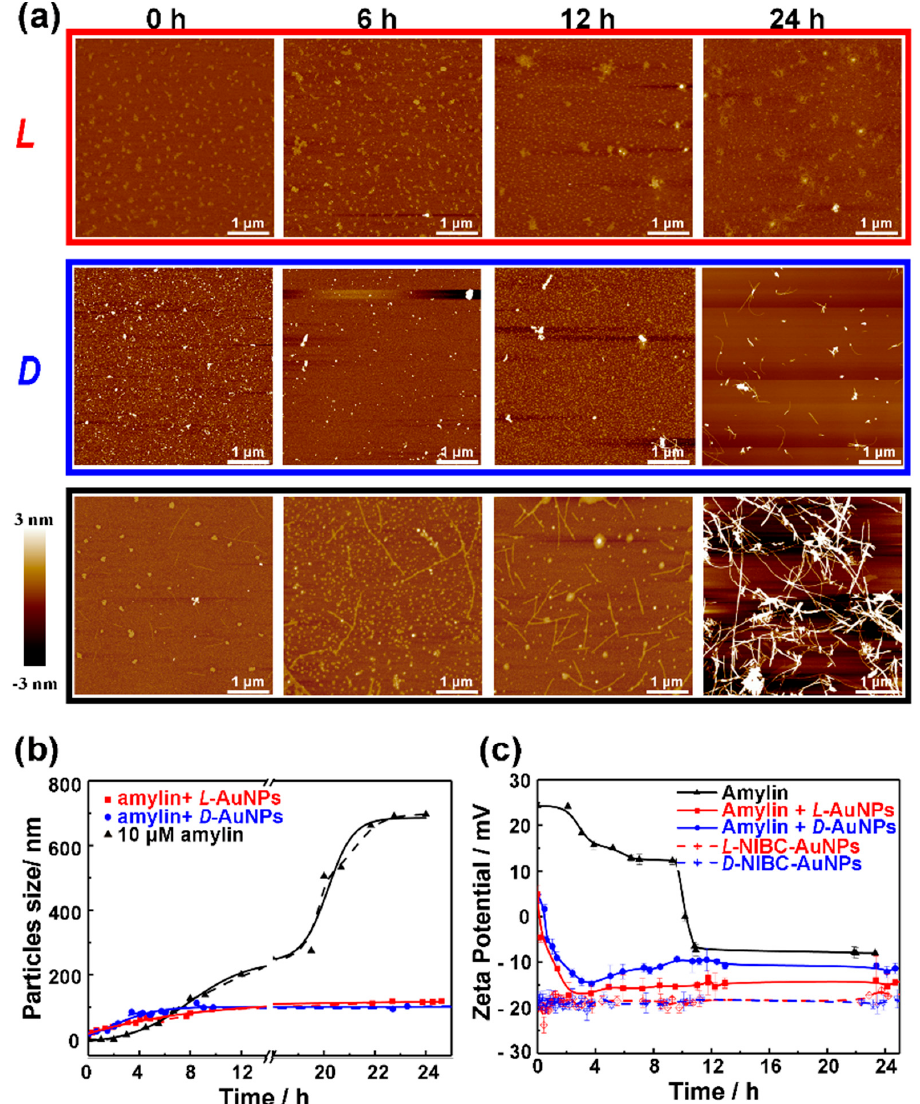
Figure 3. ( a ) Atomic force microscopy (AFM) images of amylin (10 μ mol·L − 1 ) co-incubated without (black border) or with 20 mg·L − 1 L ( D )-NIBC-AuNPs (red border: L -NIBC-AuNPs, blue border: D - NIBC-AuNPs) in PBS at 37 °C (Samples collected at 0, 6th, 12th and 24th h of the incubation). ( b , c ) Time-dependent average sizes ( b ) and Zeta potential changes ( c ) of amylin (10 μ mol·L − 1 ) co-incubated without (black curve)/with 20 mg·L − 1 L ( D )-NIBC-AuNPs (red: L -NIBC-AuNPs, blue: D -NIBC-AuNPs) in ultrapure water at 37 °C; dotted curves in c: pure L ( D )-NIBC-AuNPs.